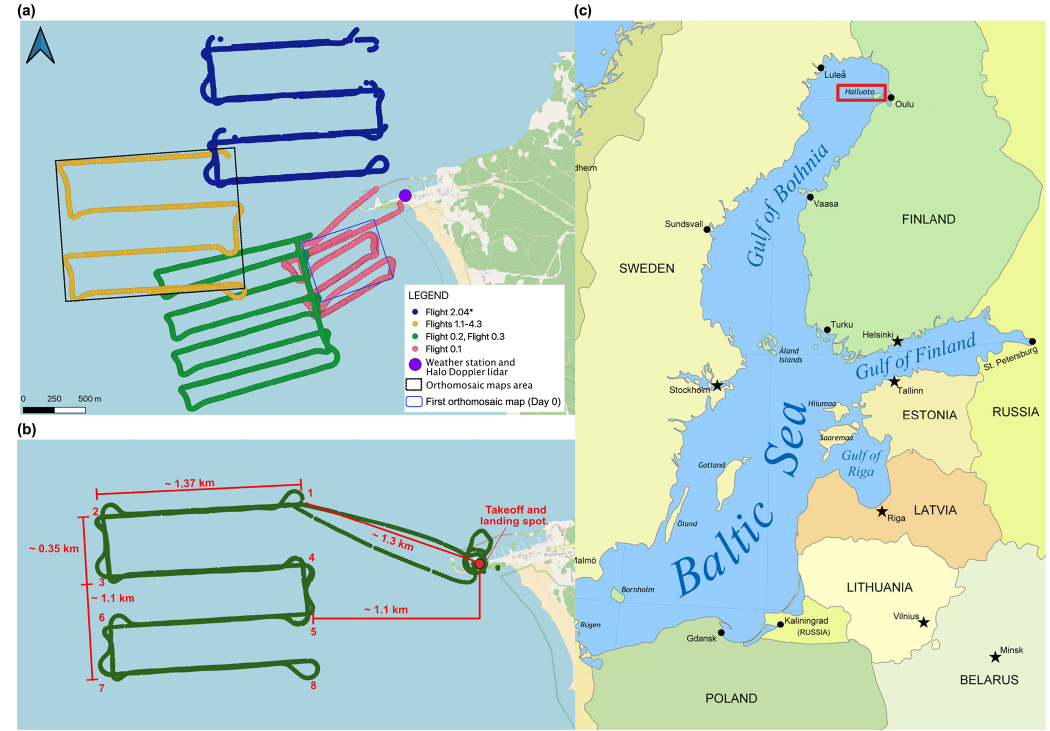
Figure 1. (a) Flight paths during the HAOS campaign, flight labels as in Table 1. (b) The flight path of the meteorological measurement mission (Table 1; flights 1.1–4.3) with distances from the takeoff and landing spot close to Marjaniemi lighthouse pier. (c) The Baltic Sea with the highlighted location of